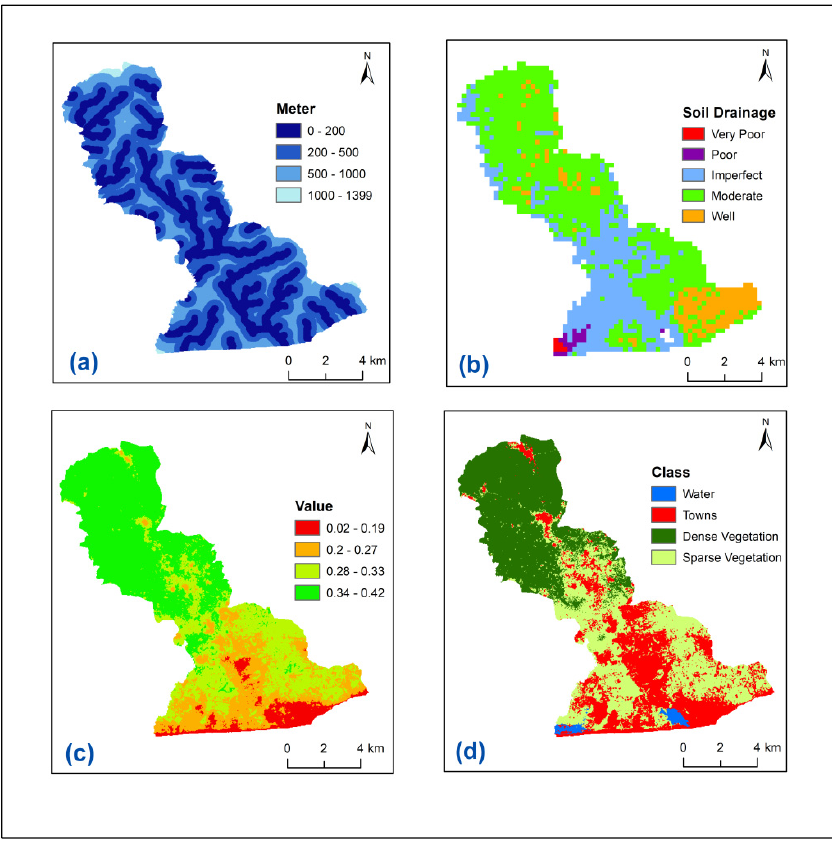
Figure 4. Remaining factors considered for flood hazard index: ( a ) distance from major streams in CCM; ( b ) soil drainage of CCM; ( c ) NDVI of CCM; ( d ) LULC of CCM.